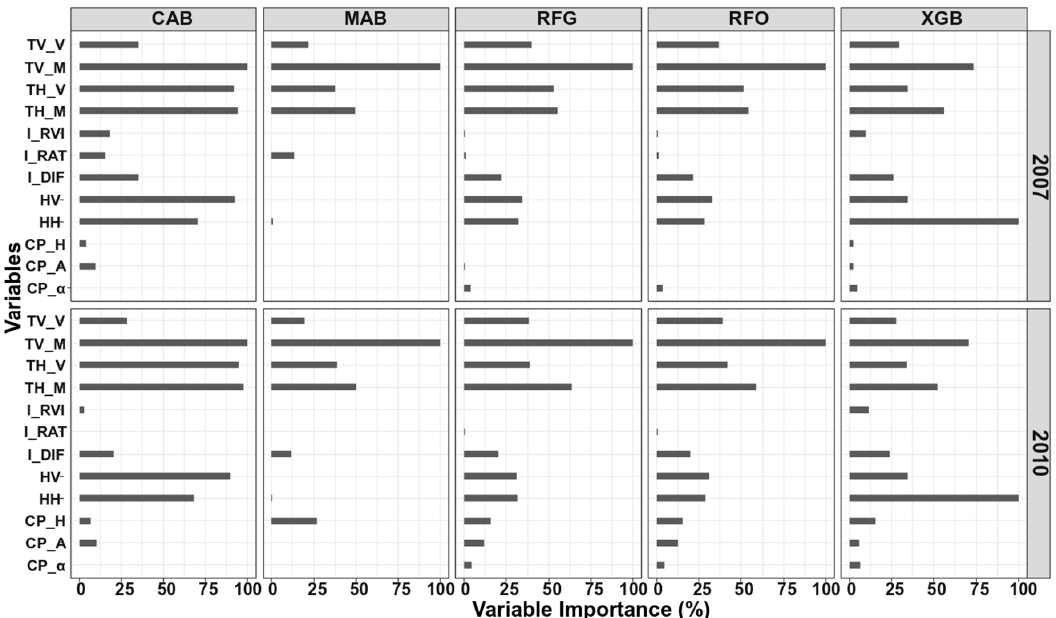
Figure 8. Variable importance derived from five classifiers including CAB and MAB, RFO, RFG, and XGB of 2007 and 2010 datasets.